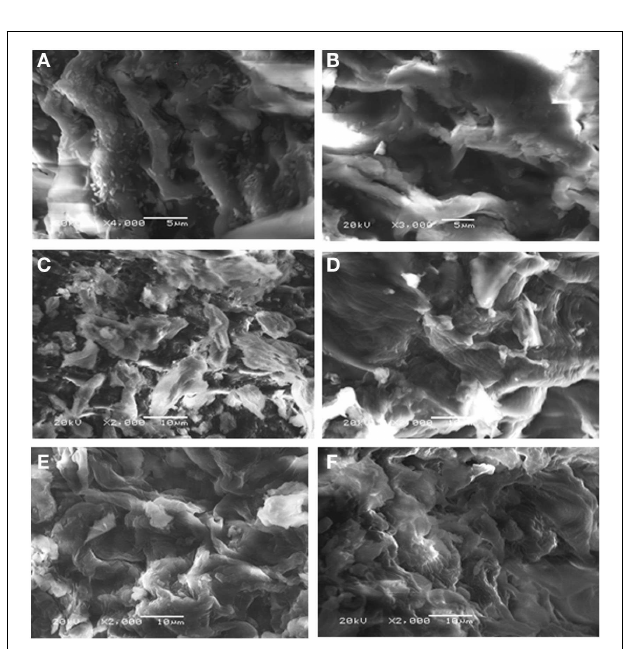
FIGURE 3 | Scanning electron microscopy micrographs showed the disruption of Sargassum biomass after the pretreatment with: (A) No treatment, (B) nanopure water, (C) acetic acid, (D) nitric acid, (E) citric acid, and (F) sulfuric acid